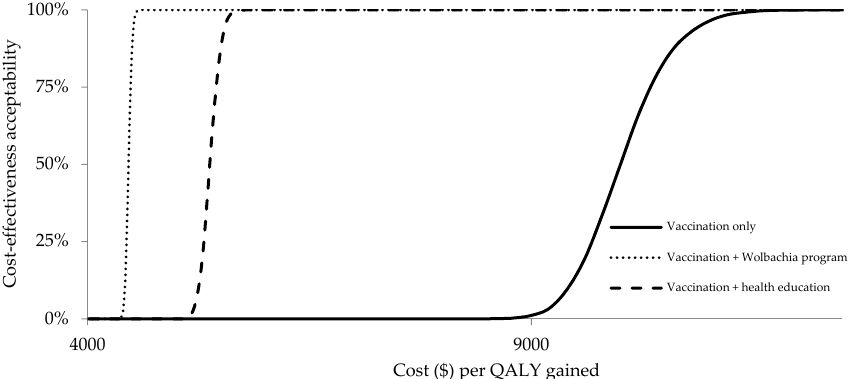
ff ectiveness acceptability curves from the healthcare perspective. Int. J. Environ. Res. Public Health 2020 , 17 , x Figure 6. Cost-effectiveness acceptability curves from the healthcare perspective. Figure 6. Cost-e